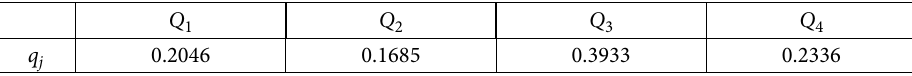
Table 5. The attributes weights q j